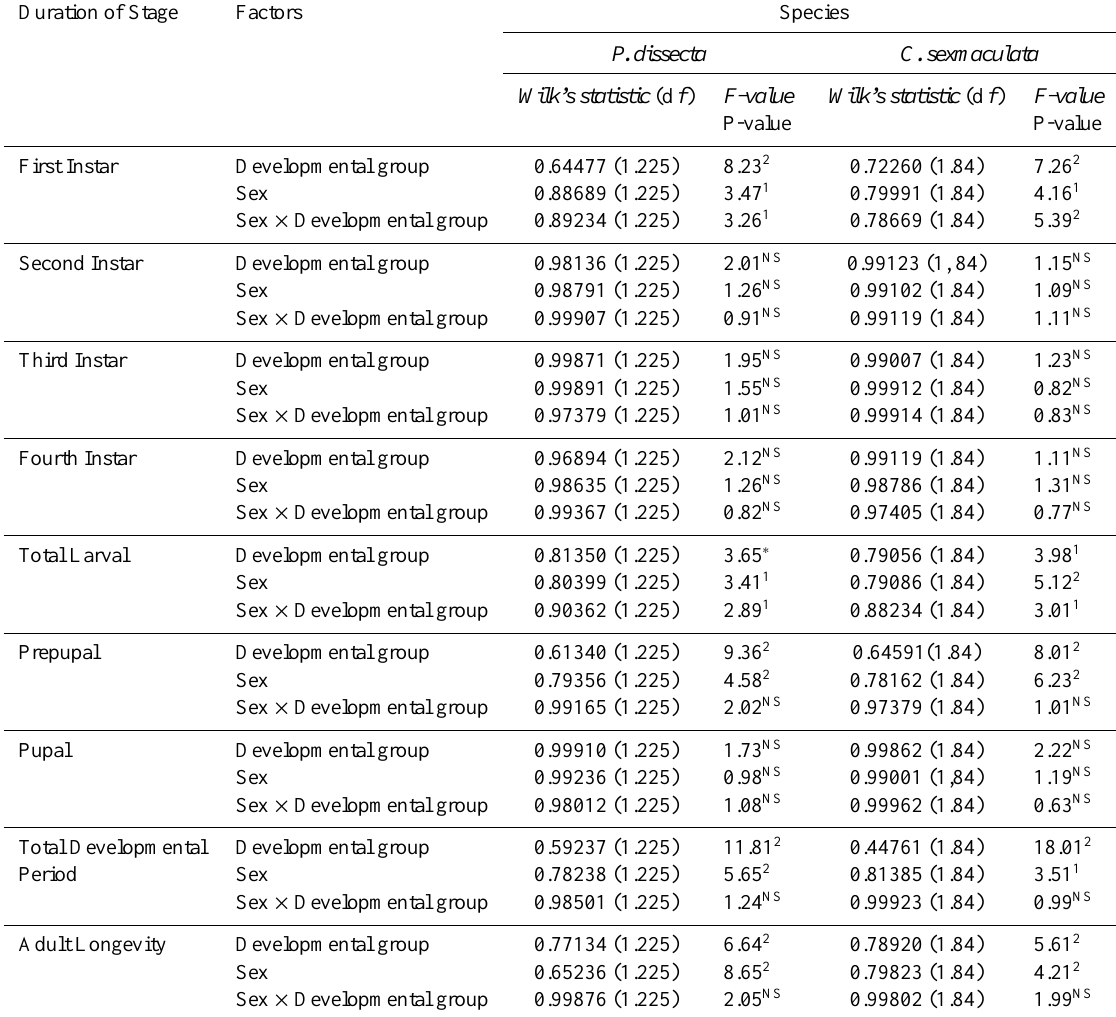
Table 1. Results of General MANOVA of certain life history traits of C. sexmaculata and P. dissecta